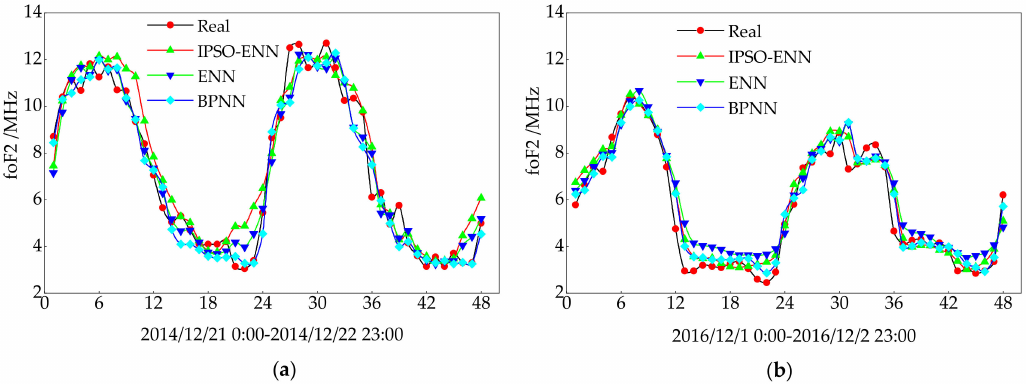
Figure 6. The diurnal performance comparison. ( a ) Observed and predicted values in 2014; ( b ) observed and predicted values in